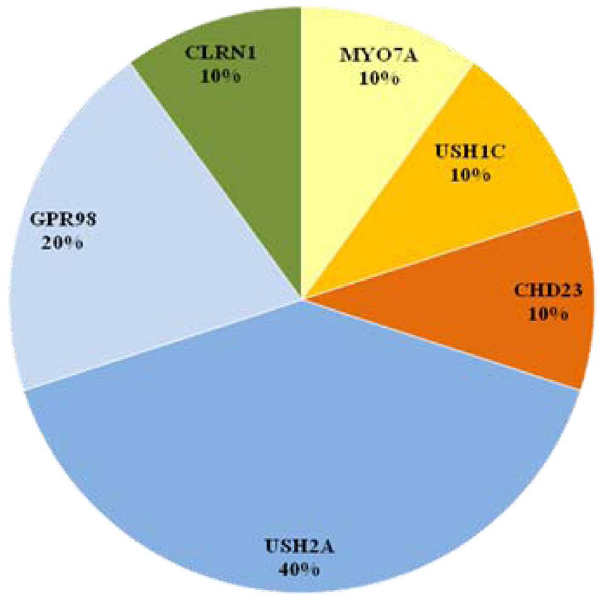
Figure 3. Distribution of mutated genes in ten Lebanese families with USH. Among these ten families, eight are described